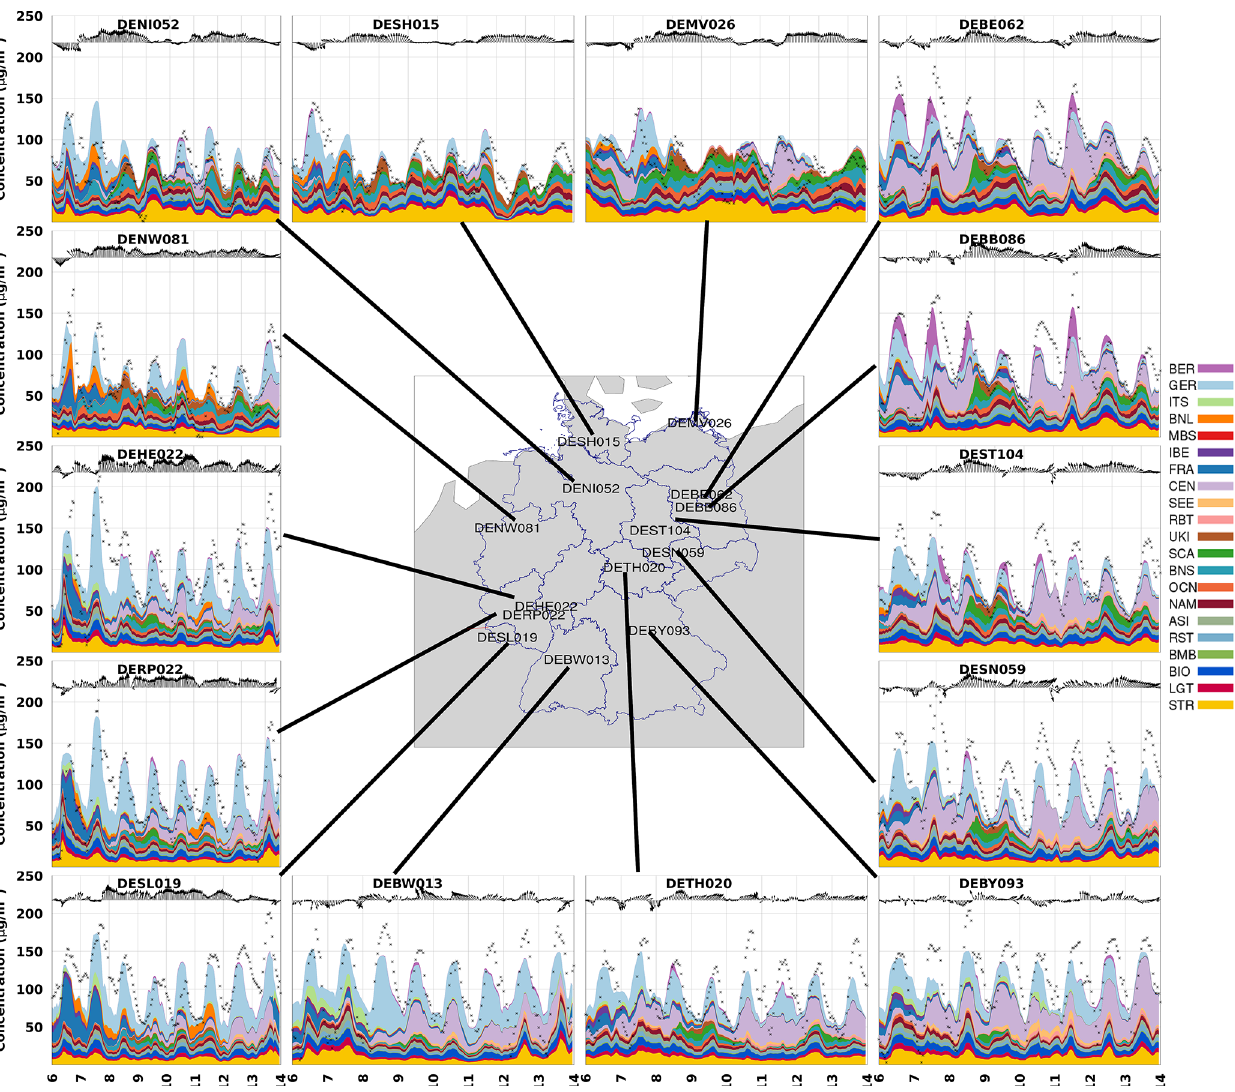
Figure 6. Contribution of regional NO x sources to hourly O 3 concentrations of local and other European sources, HTAP2 source regions, and other global source types at each station during the 6–13 August 2015 period. In addition, the vectors along the top of each panel represent the calculated wind speed and direction at 10ma.g.l. The black dots represent the observed O 3